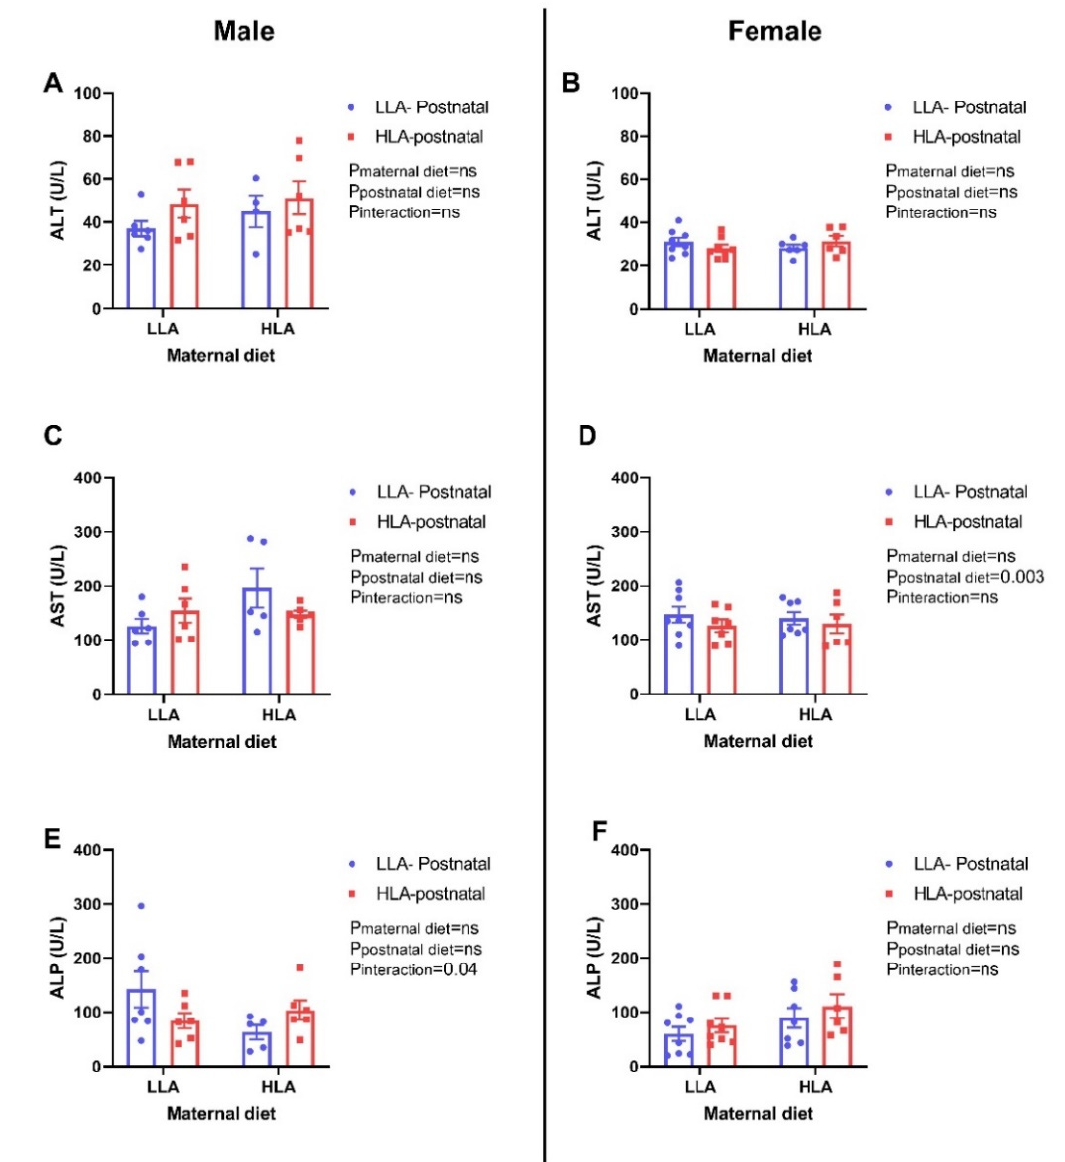
Figure 6. Effect of a maternal and postnatal diet high in linoleic acid on circulating liver enzymes in adult offspring. Data are presented as mean ± standard error of the mean (SEM). Two-way ANOVA was performed for statistical analysis with maternal diet and postnatal diet as two factors. n = 5–8. LLA: low linoleic acid; HLA: high linoleic acid; PN: postnatal; ALT: alanine transaminase; AST: aspartate transaminase; ALP: alkaline phosphatase. A : ALT concentration male; B : ALT concentration female; C : AST concentration male; D : AST concentration female; E : ALP concentration male; F : ALP concentration female.